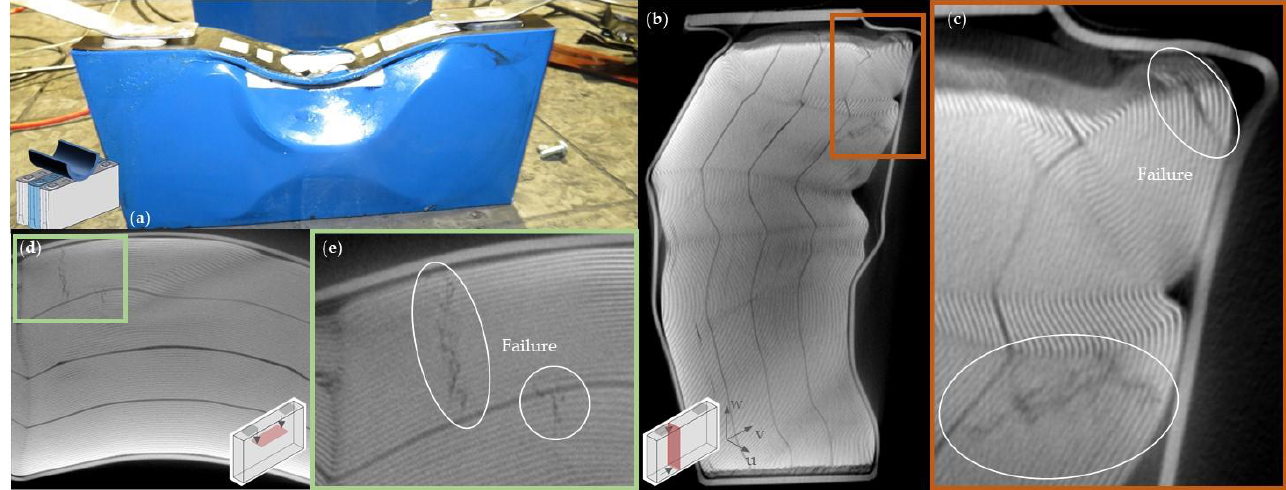
17 of 21 Figure 17. W-direction with hemispherical impactor: ( a ) deformed middle cell; ( b , c ) CT-Scans. Finally, CT-Scans of the cylindrical test in the w-direction were investigated, as Fig- ure 18 contains different cross-sections of the middle cell involved in the abuse testing.